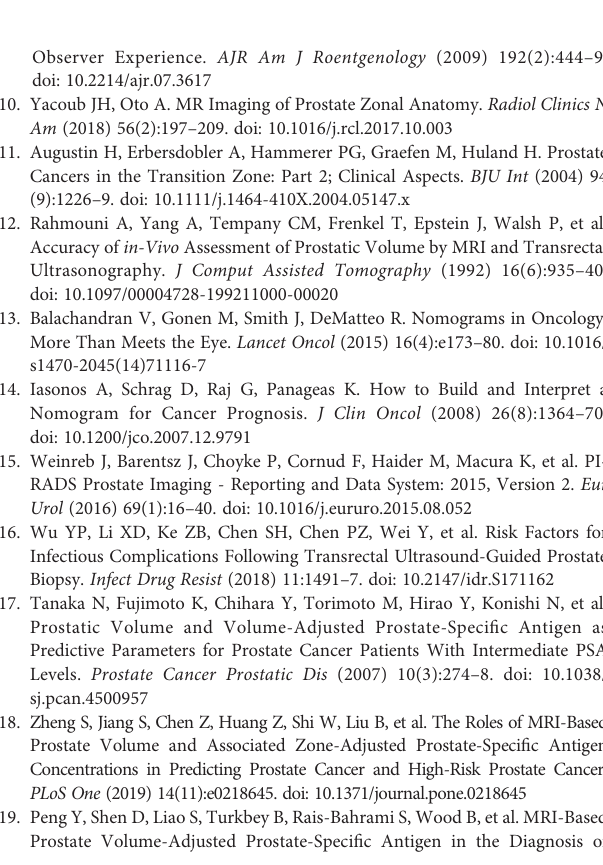
Supplementary Figure 1 | Prostate location and MR imagine in transverse (A) , sagittal (B) and coronal (C) plane. Red: Central gland sectional area, CGA; Blue: Peripheral zone sectional area, PZA. Supplementary Figure 2 | Correlation analysis among each predictor used to eliminate combinations including collinear predictors. Supplementary Figure 3 | Nomogram predicting the probability of PCa at the initial biopsy based on model 2 (A) and model 3 (B) . Supplementary Figure 4 | Calibration plot in training cohort and validation cohort and predictive accuracy for PCa at initial biopsy based on model 2. Supplementary Figure 5 | Calibration plot in training cohort and validation cohort and predictive accuracy for PCa at initial biopsy based on model